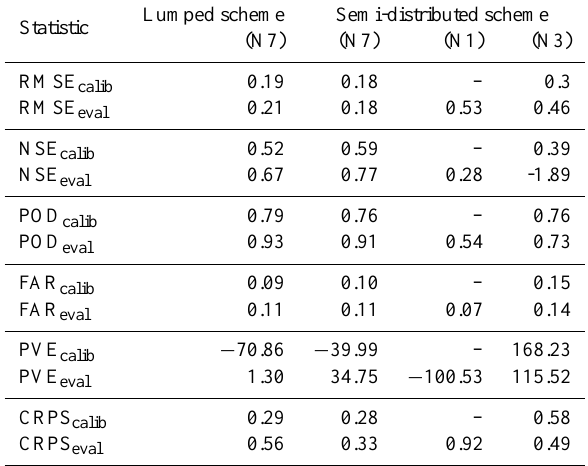
Table 2. Model evaluation at the catchment outlet (N7) and at the inner catchments (N1 and N3), for calibration and evaluation peri- ods. RMSE and PVE statistics are in units of